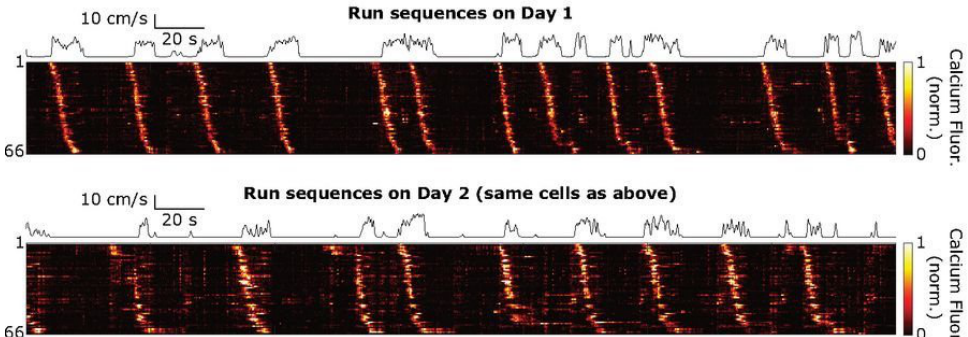
Figure 4. An example of a precise temporal motif observed in two subsequent days. In this study by [109], an analysis of calcium fluorescence (heatmap) of hippocampal CA1 neurons participating to run sequences in consecutive imaging sessions shows repetitions of precise spiking motifs with a time scale of the order of seconds. Cells were selected and ordered with respect to their activity in the first imaging session. The black line on top represents the speed of the mouse. Futher analysis showed that more than the majority of the cells participating in run sequences on the first day were recruited again in run sequences on the next day. Modified from Figure 1-A from [109] under the CC-BY PNAS